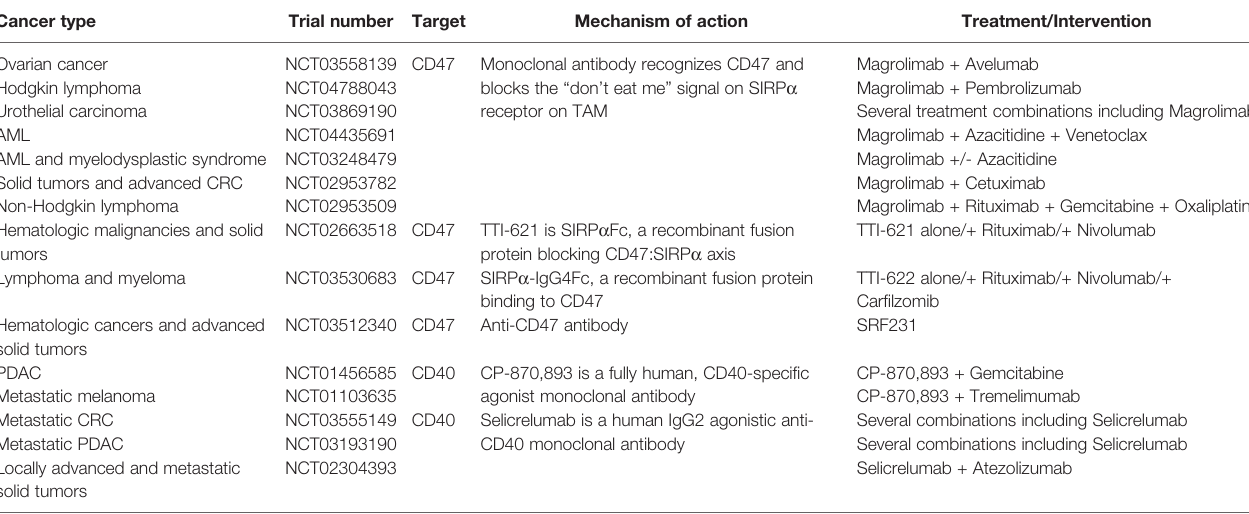
TABLE 5 | Clinical trials investigating reprogramming of TAM in combination with other